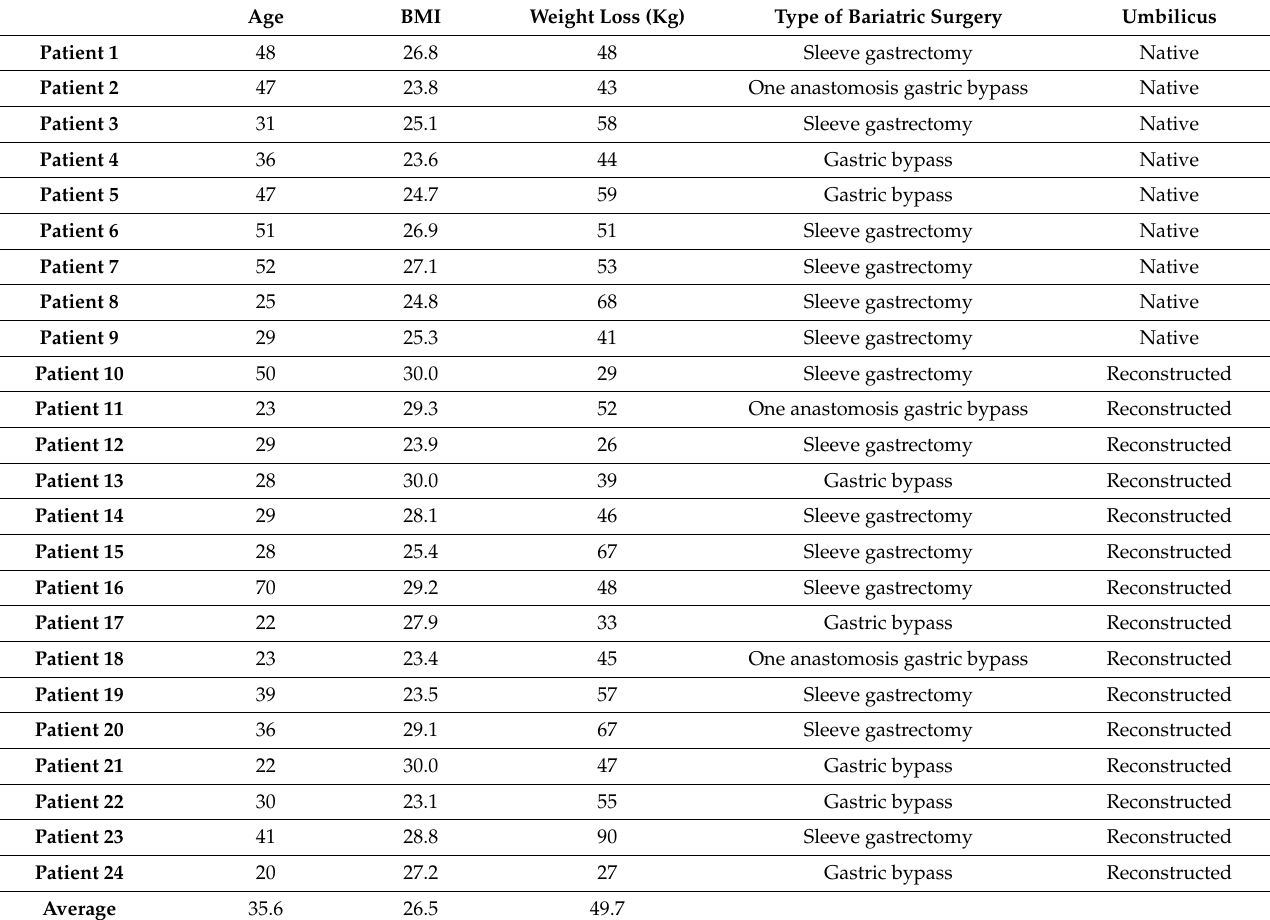
Table 3. Patients’ Table 3. Patients ’ Characteristics.